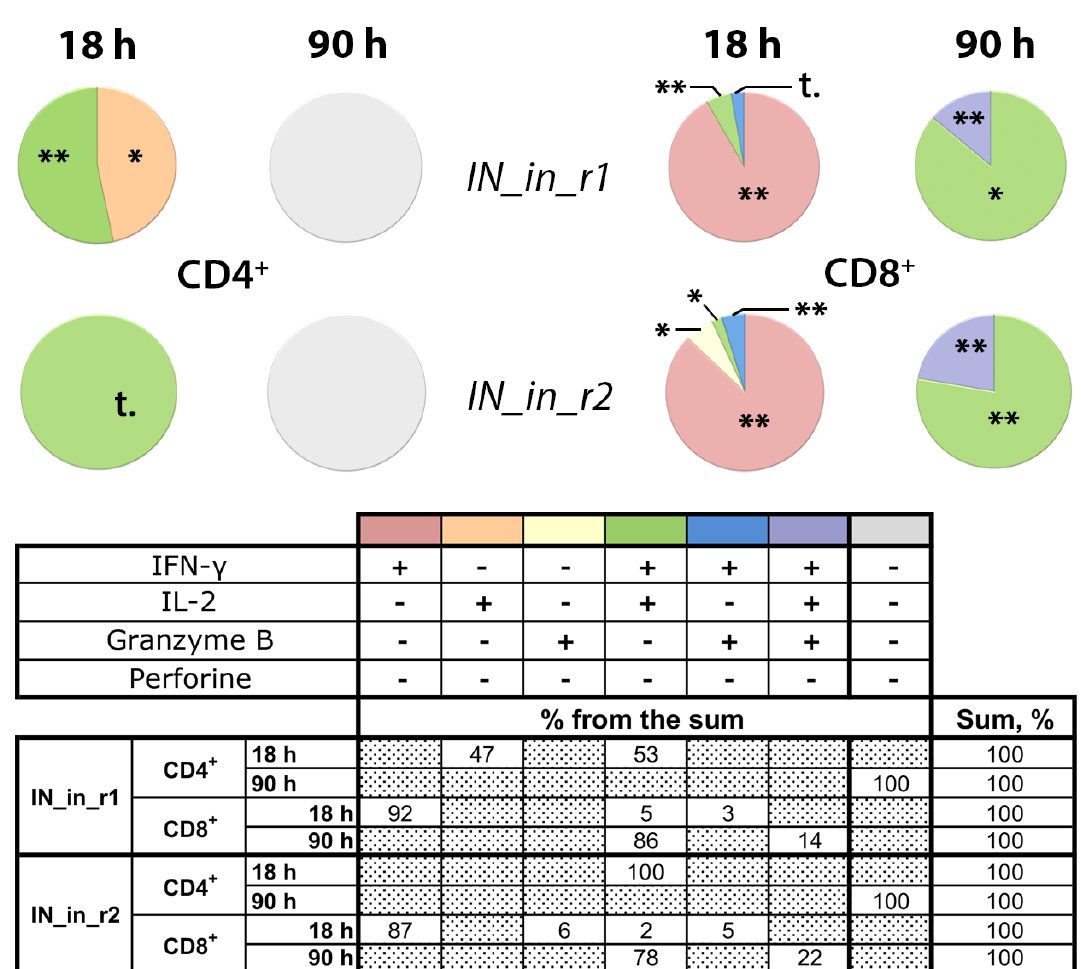
Figure 11. DNA immunization of BALB/c mice with consensus HIV-1 clade A integrase with mutations conferring resistance to raltegravir induces potent lytic response of CD8+ T-cells. Mice were DNA immunized with IN_in_r1 or IN_in_r2, or empty vector (Table 1, Series II). Splenocytes of mice were in vitro stimulated with MIN peptide pool (Supplementary Table S1) for 18 or 90 h (see Materials and Methods). Percent of CD4+ and CD8+ T cells producing IFN- γ , IL-2, Granzyme B, and perforin was assessed by flow cytometry with ICCS. Media values were subtracted, and data entries for two independent runs, each done in duplicate, were pooled, and statistical analysis was performed of the differences between values exhibited by MIN stimulated splenocytes of IN and of vector-immunized mice. Thereafter, for each T cell population, we subtracted mean percent of responding cells in vector-immunized mice from respective mean values exhibited by IN DNA-immunized mice. Resulting values are presented in circular diagrams as shares of the total responsive CD4+ or CD8+ T cell populations, altogether constituting 100%, and are presented in the table below the graph; the colors of the sectors of the pie diagram match the color used for this combination of cytokines in the table; “+” and “ − “ in the head of the table below the diagrams; dotted boxes correspond to no detectable cells of a given type. Groups did not differ in cell viability, levels of unspecific reactivity, and response to stimulation with mitogens ConA and PMA. **— p < 0.01, *— p < 0.05, statistically significant difference, and “t”, tendency for difference with vector-immunized mice ( p < 0.1) using Mann–Whitney test after the Holm/Hochberg multiple comparisons correction.